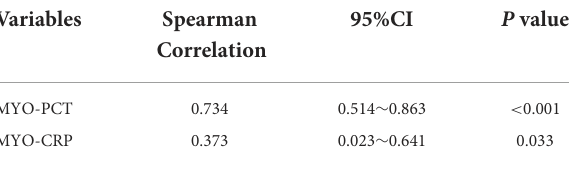
TABLE 7 Correlation of MYO and inflammatory biomarkers in children with